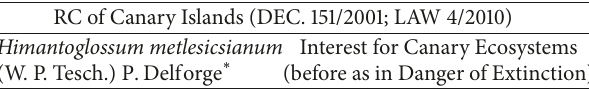
Table 9: Species included in the regional catalogue (RC) of Canary Islands (DEC. 151/2001; LAW 4/2010).